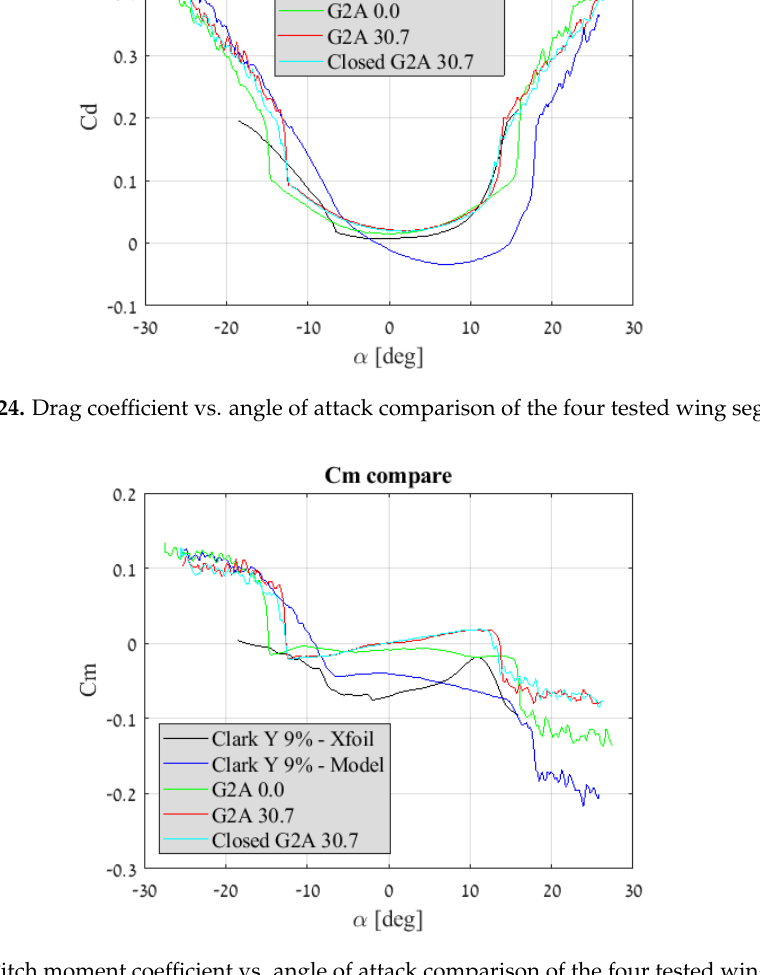
Figure 25. Pitch moment coefficient vs. angle of attack comparison of the four tested wing